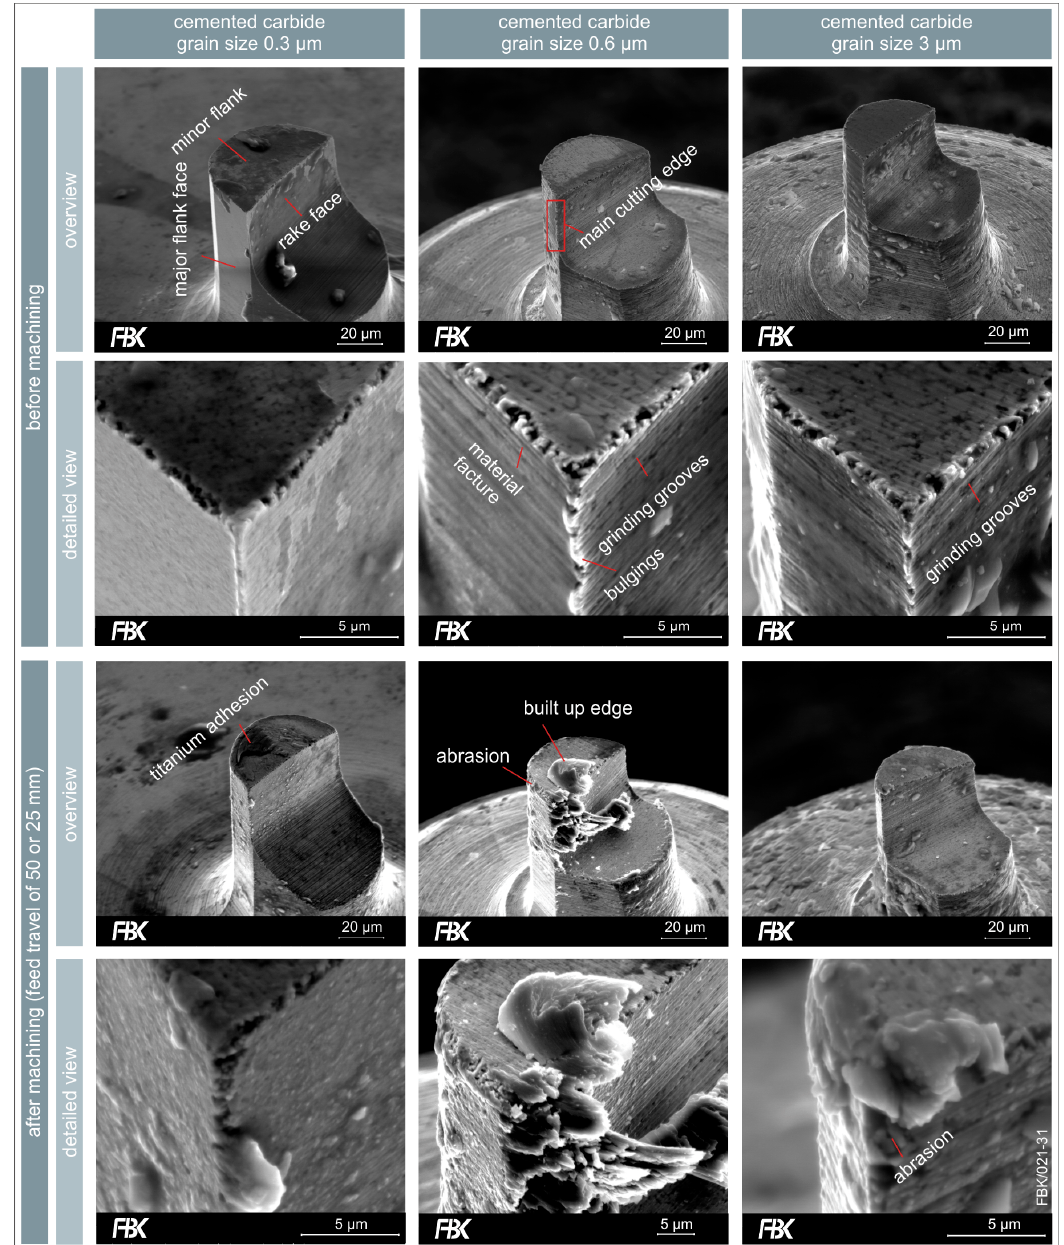
Figure 11. Influence of cemented carbide specifications on tool quality and wear in dependence of the grain size (from left to right: 0.3 µm, 0.6 µm and 3 µm) before ( top ) and after machining ( bottom ).